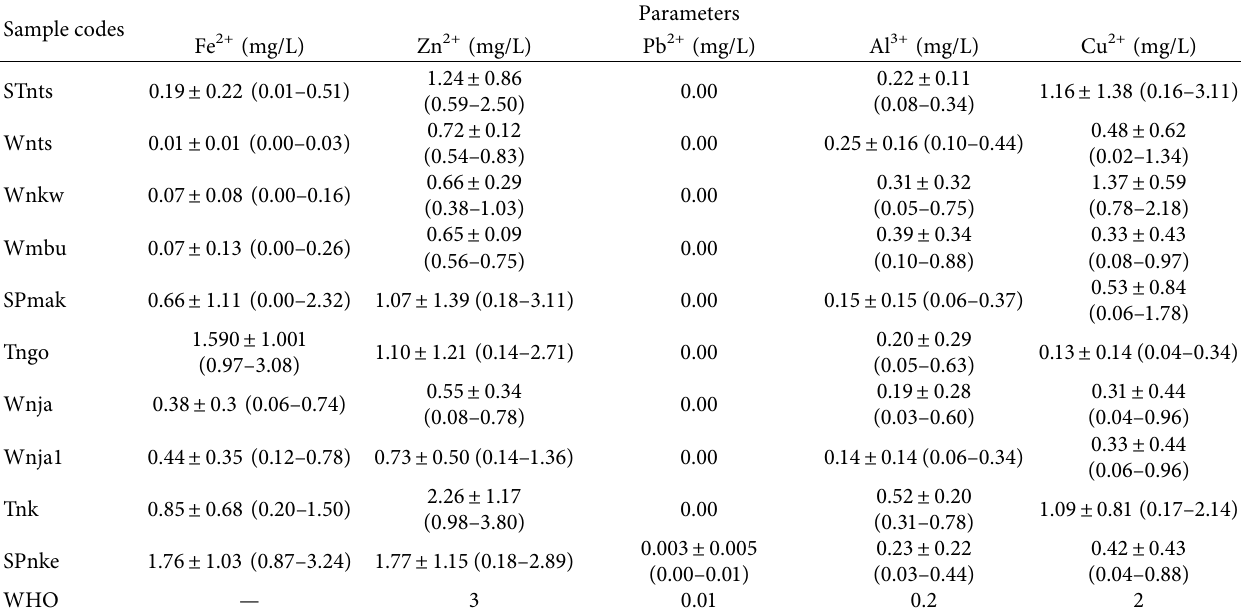
Table 5: Results of analysed heavy metals in the samples from ten water sources in Bangolan within the study period. Sample codes